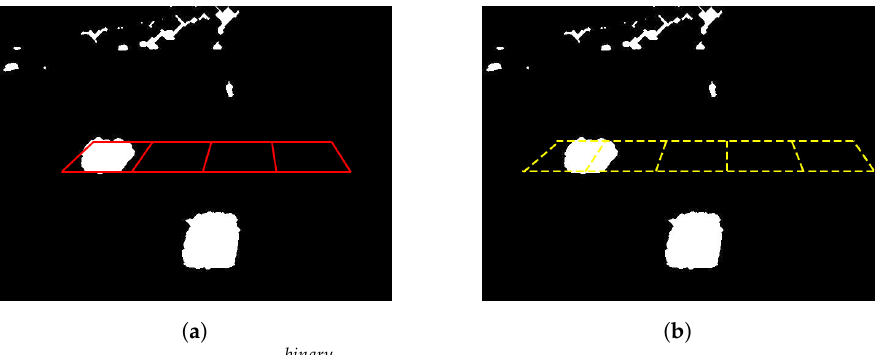
Figure 13. Binary detection I binary set with ( a ) primary loops and ( b ) secondary 539